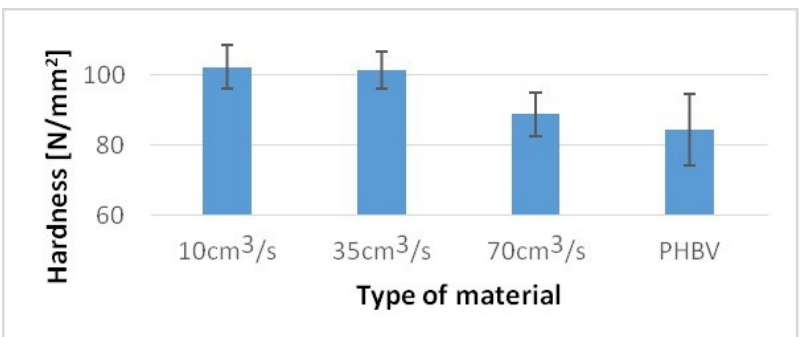
Figure 7. Hardness of tested samples produced at a variable injection rate compared to a pure PHBV sample produced at 35 cm 3 /s.